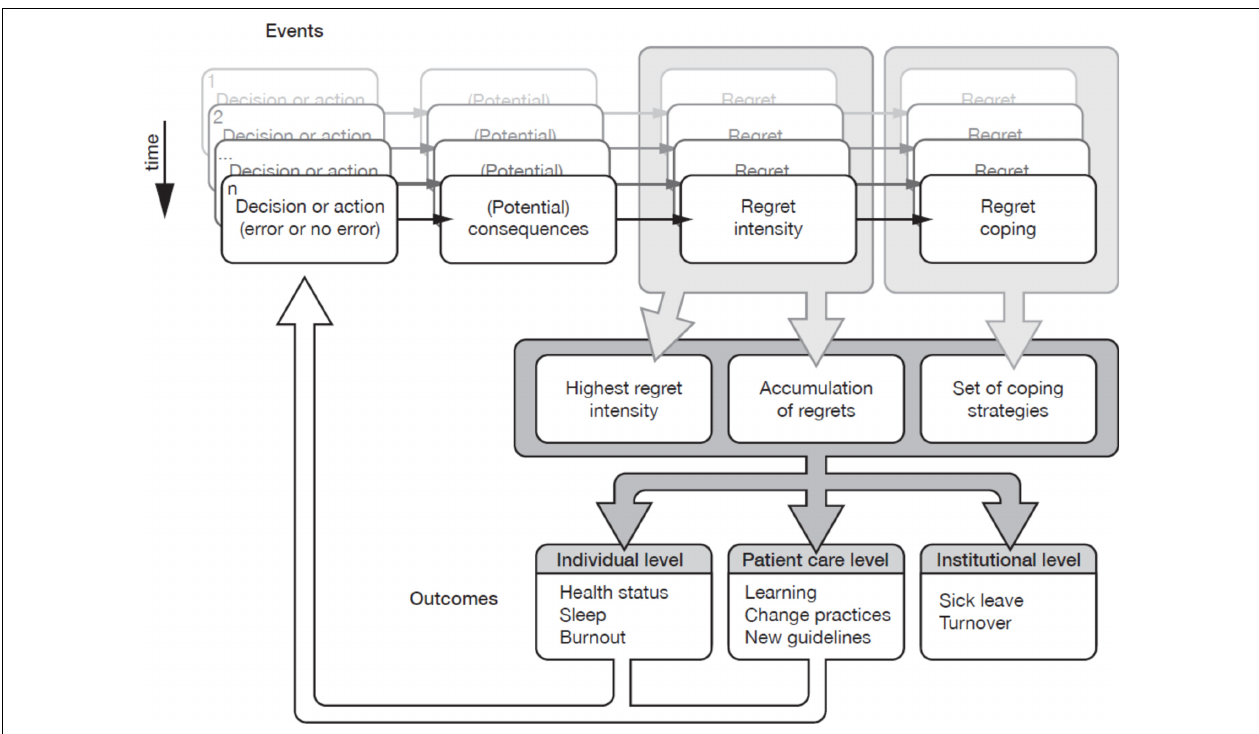
FIGURE 1 | Theoretical framework of experiencing regret in clinical practice and its implications. Lancet (Courvoisier et al., 2013b).